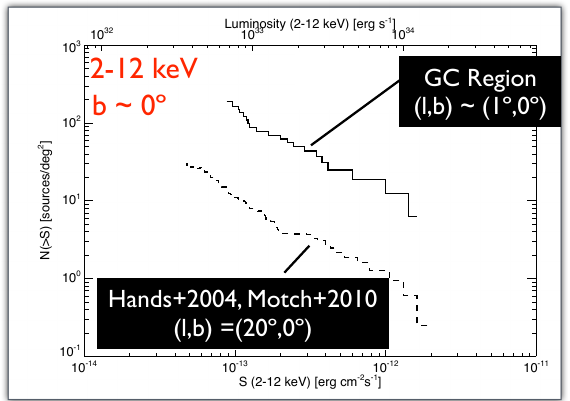
Figure 3: logN – logS curves of hard sources ( > 2 keV) in the direction of the Galactic Center. The expected extragalactic contribution from Mateos et al. 2008 has been